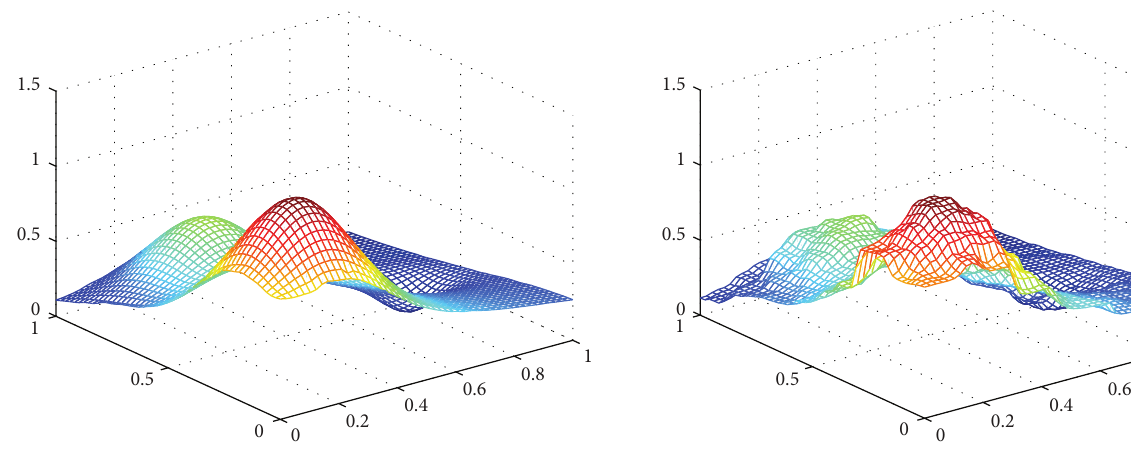
Figure 9: The graph of WLRBF based on Figure 4. Figure 10: The graph of Shepard interpolation based on Figure 4.